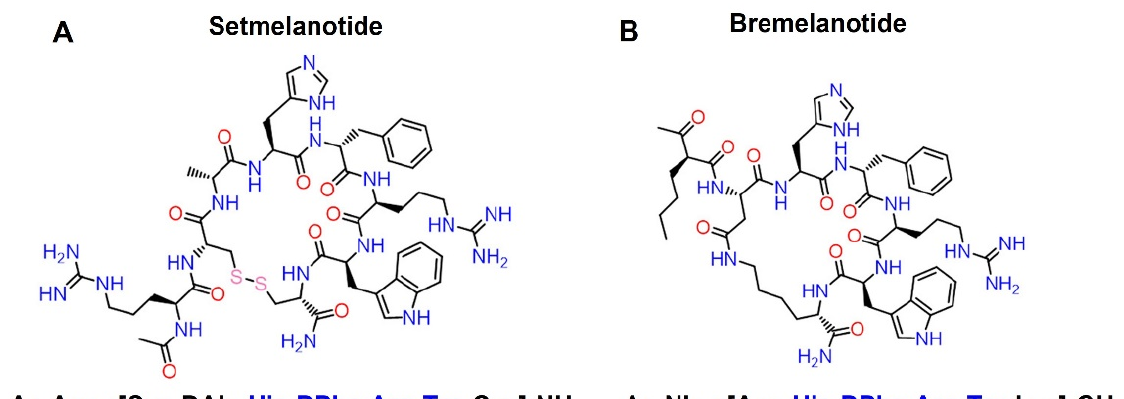
Figure 3. Amino acid sequences and chemical structures of setmelanotide ( A ) and bremelanotide ( B ). The functional motif is shown in blue.